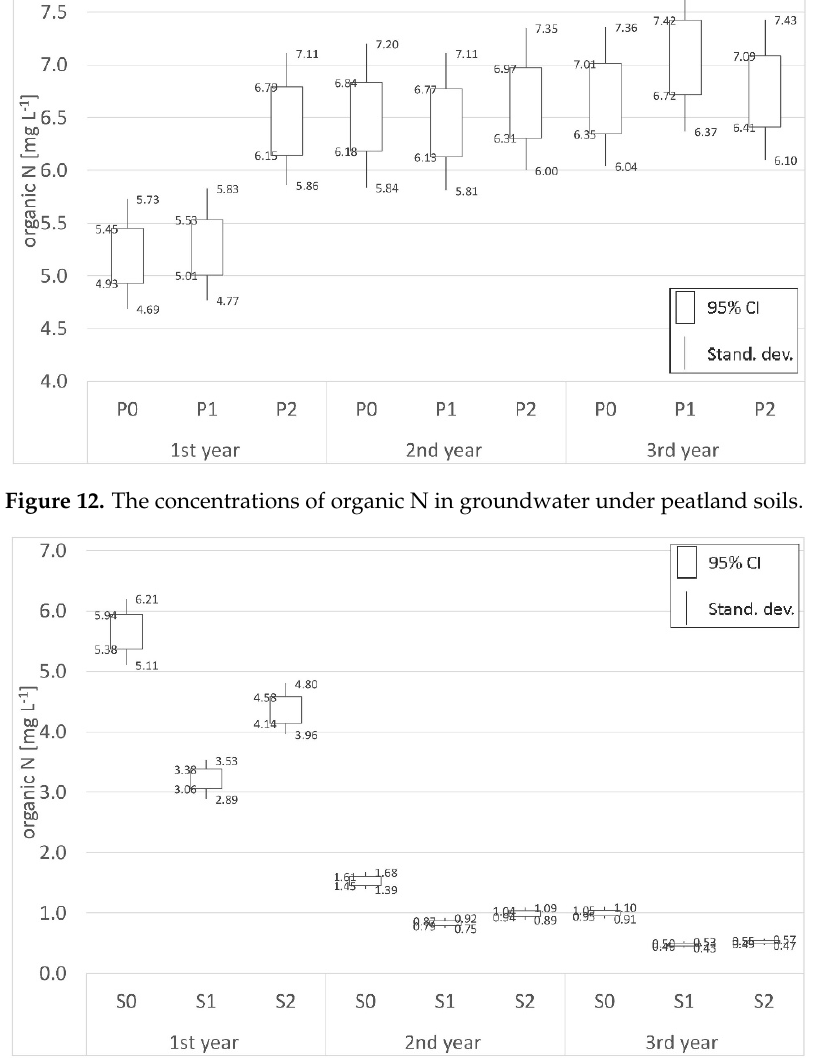
Figure 13. The concentrations of organic N in groundwater under shelterbelt soils.